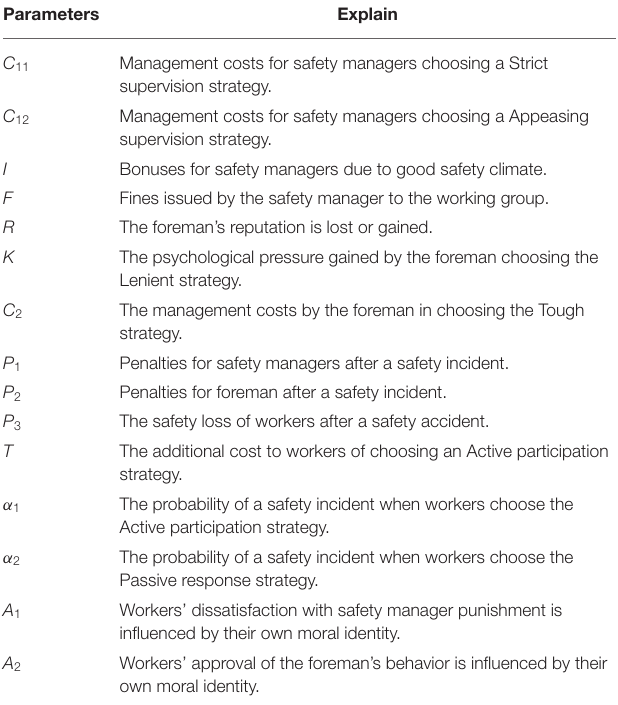
TABLE 2 | Explain of the parameters. Parameters